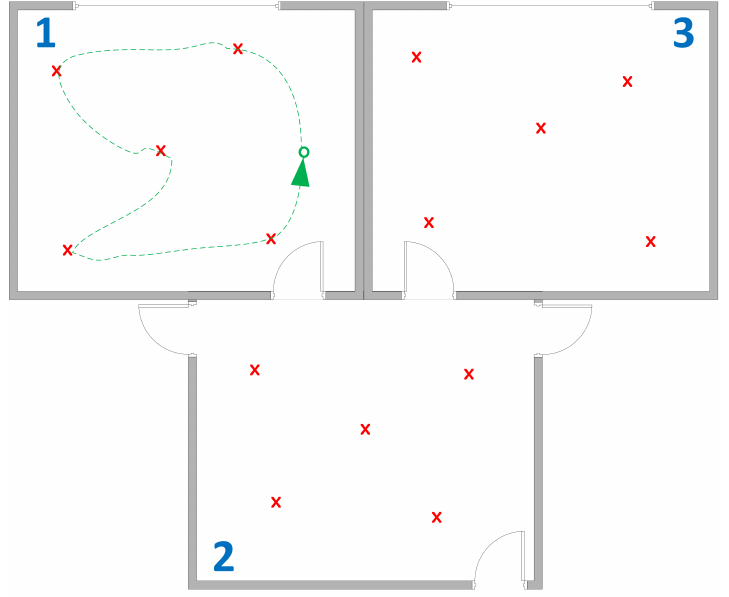
Figure 15. The three rooms’ layout, with the room number. The green circle is the starting point while red crosses are points where Andruino-R2 stopped to collect Wi-Fi